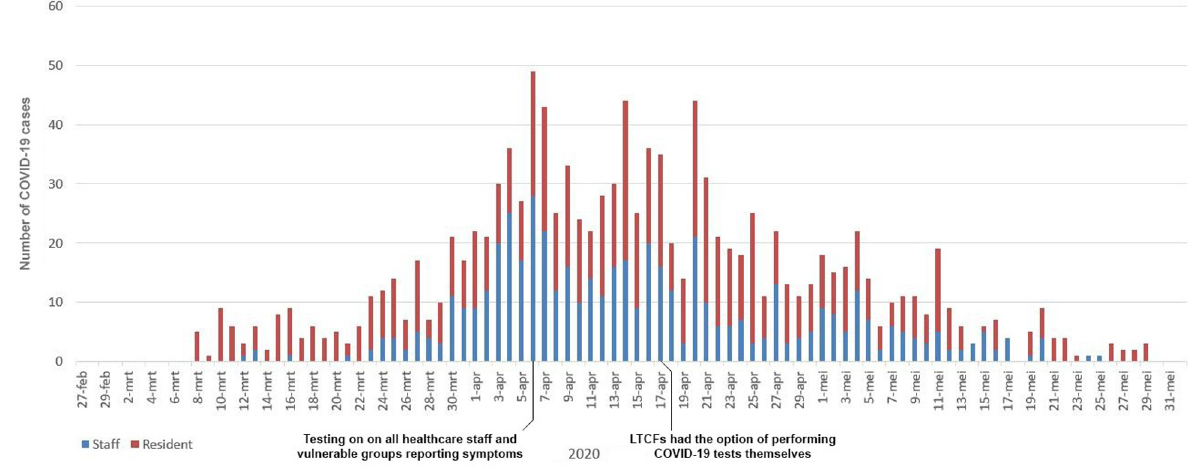
Fig 2. Epidemiological curve of COVID-19 cases by generated starting date, the Netherlands, 27 February –1 June 2020 (n = 1,208).